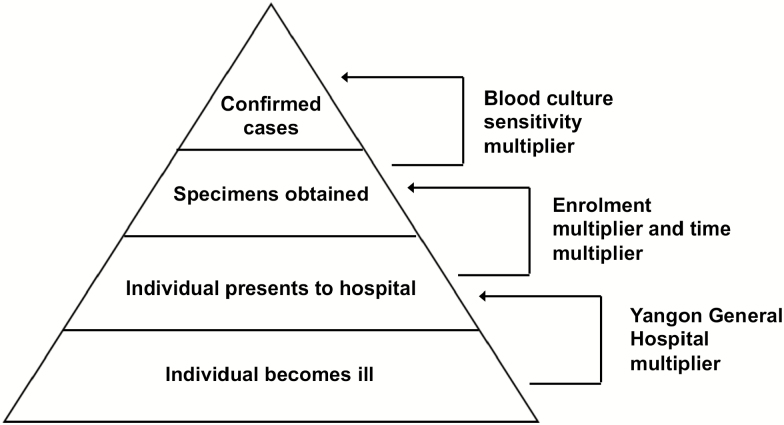
Surveillance pyramid showing multipliers used to account for incomplete case identification. Modified from Crump et al [16].